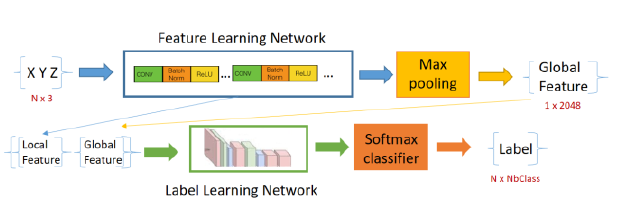
Figure 2. Fully convolutional neural network for bathymetric point cloud